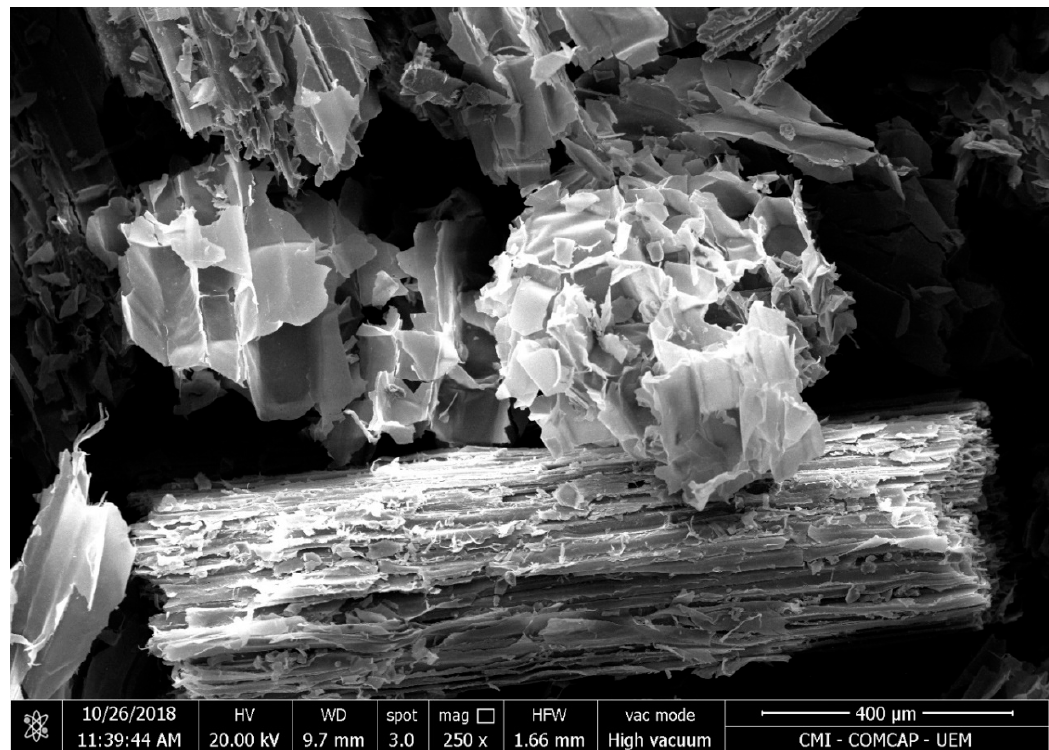
Figure 1. SEM micrograph of general view of the sample of sugarcane bagasse (SCB), showing fibers and residues with 250× magnification.